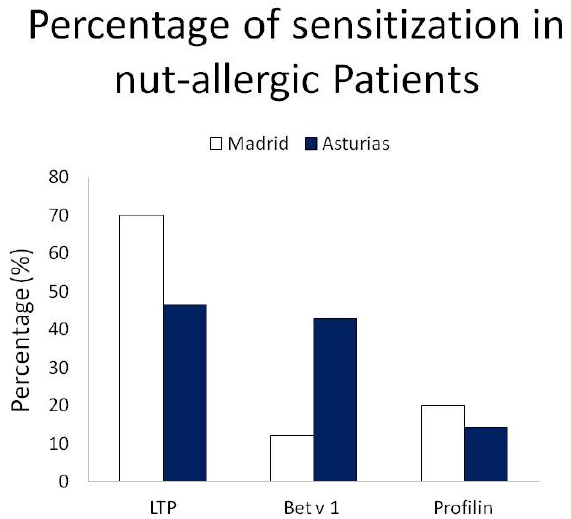
Figure 1. Differences in molecular pattern between Madrid and Asturias.